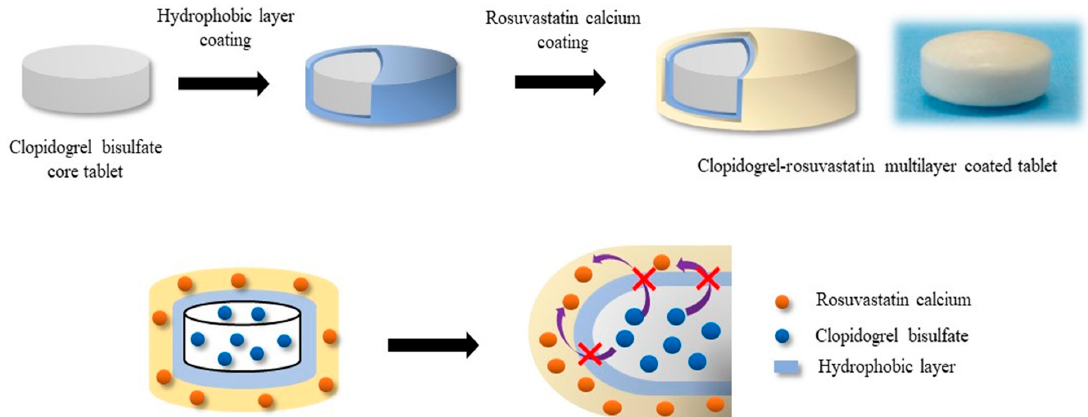
Figure 2. Structural illustration of the multilayer-coated tablet containing clopidogrel and rosuvastatin.